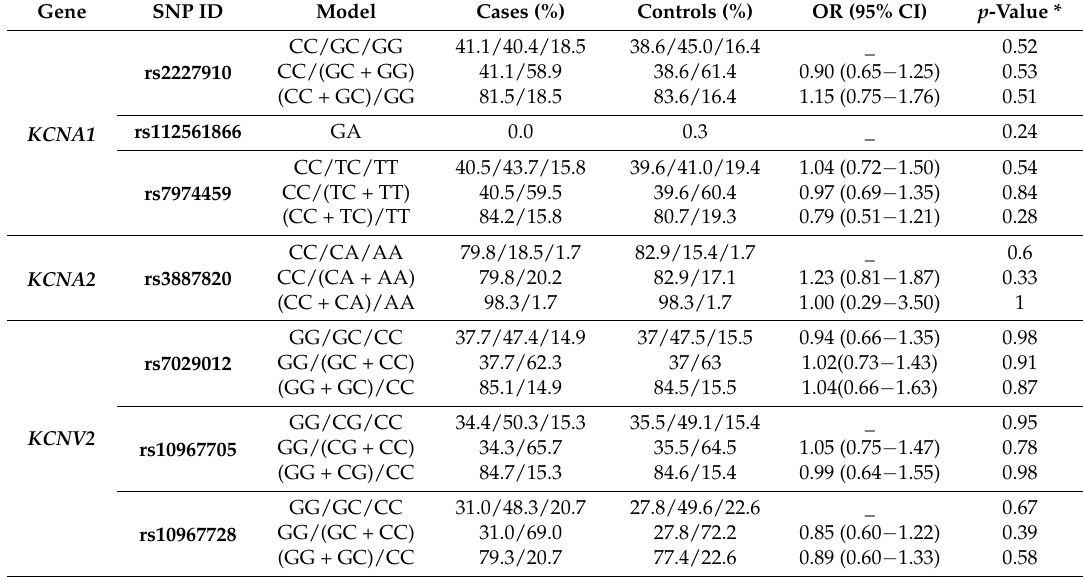
Table 1. The distributions of Kv-associated single nucleotide polymorphisms (SNPs) in 296 epileptic patients and 299 healthy